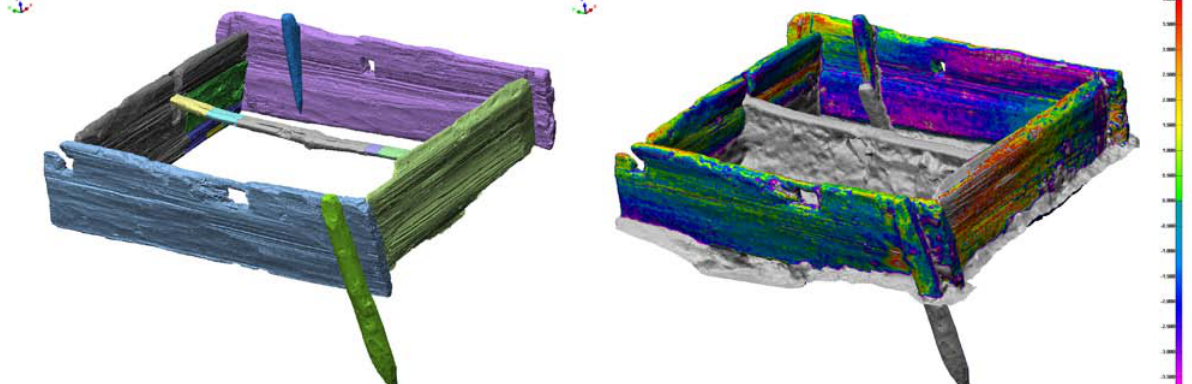
Figure 7. The virtual reconstruction of the archaeological find after the combination of different datasets (left) and the comparison of short-range- and terrestrial laser scanning datasets